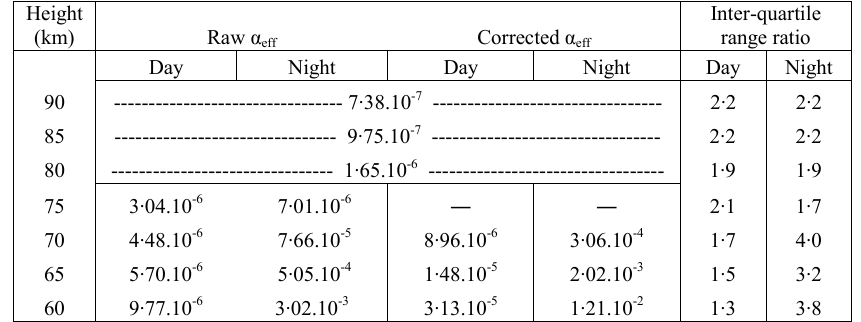
Table 2 Table 2. Estimates of effective recombination coefficient during the proton event of 28–29 October 2003. These are median values over the whole assembly of 5-min determinations, both raw and (where possible) corrected values.